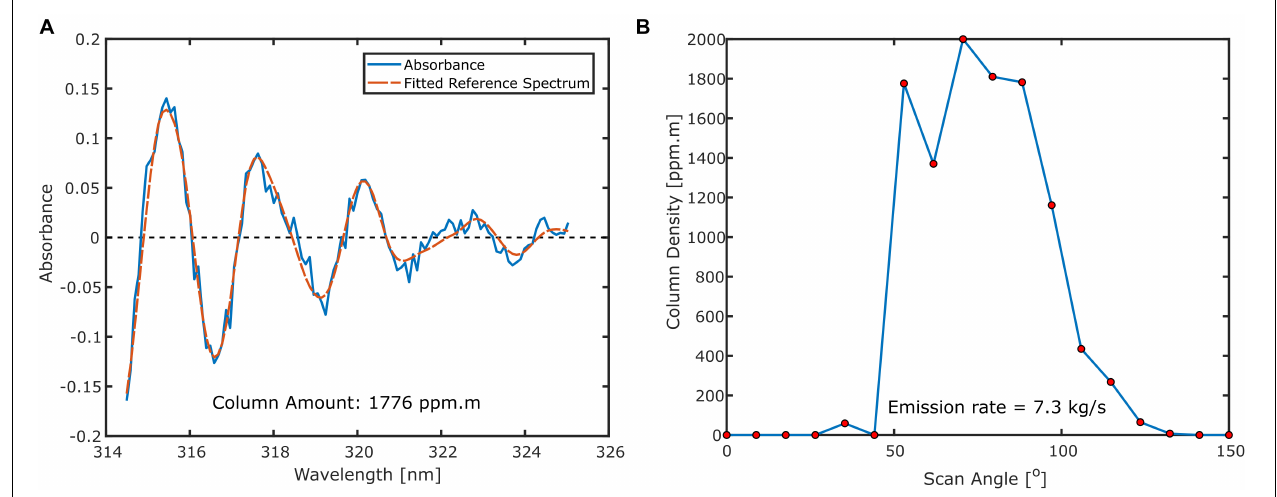
FIGURE 5 | (A) Example DOAS retrieval (fit window of 314.5–325 nm) from the scan presented in (B) . (B) A full PiSpec scan taken from the Santiago crater rim between 21:04 UTC and 21:15 UTC, on 14th June 2017. The resulting emission rate computed from the scan was 7.3 kg s − 1 .